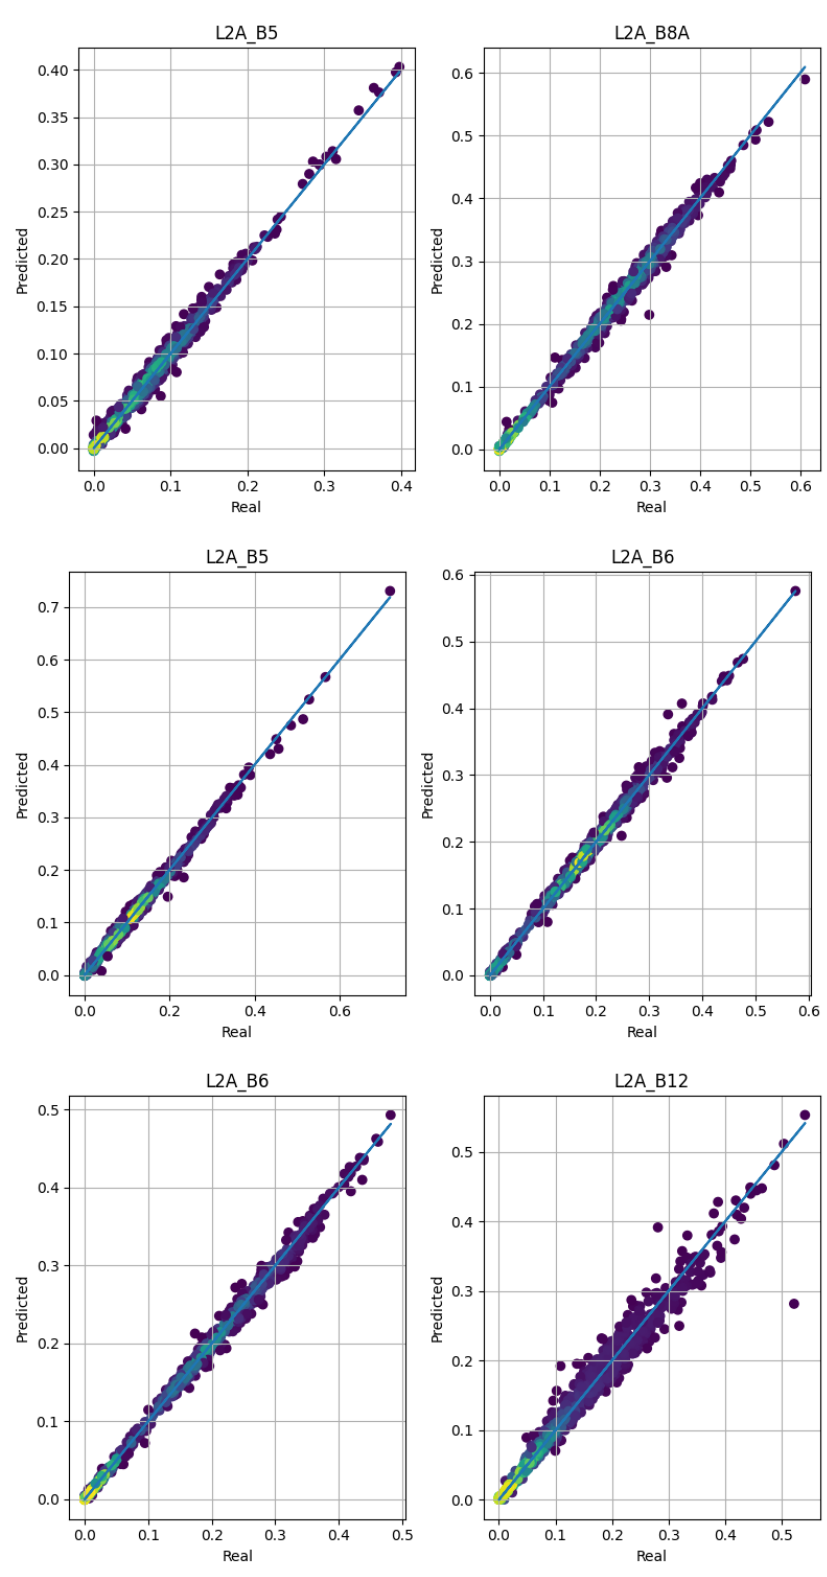
Figure 12. Scatterplots for the double-band regression (L2A). Each row in the figure corresponds to a row in Table 16. The colors Figure 7. Scatterplots for the single band regression (L1C). The colors indicate the density of points. indicate the increasing density of